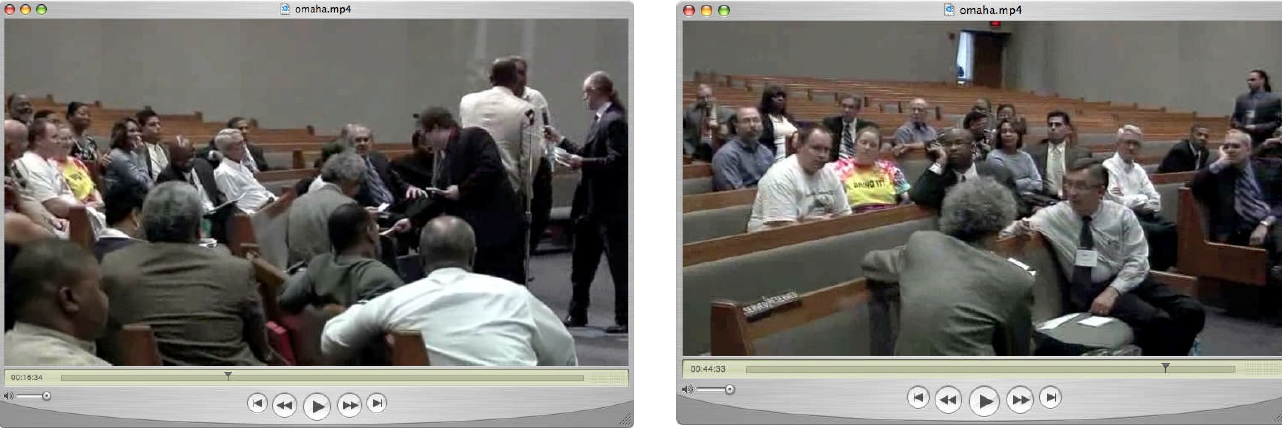
Figure 9: Delivery and visible screening of the Question